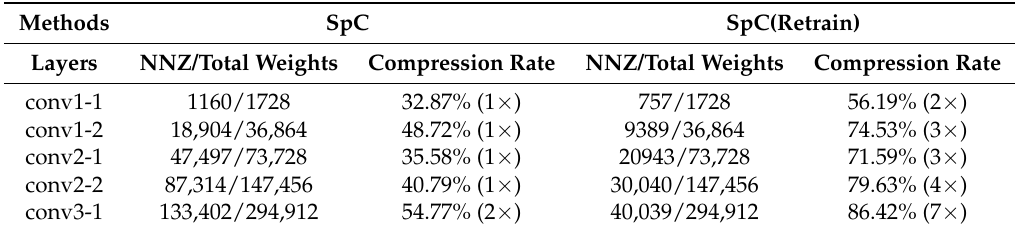
Table A3. Layer-wise compression of VGGNet (CIFAR-10